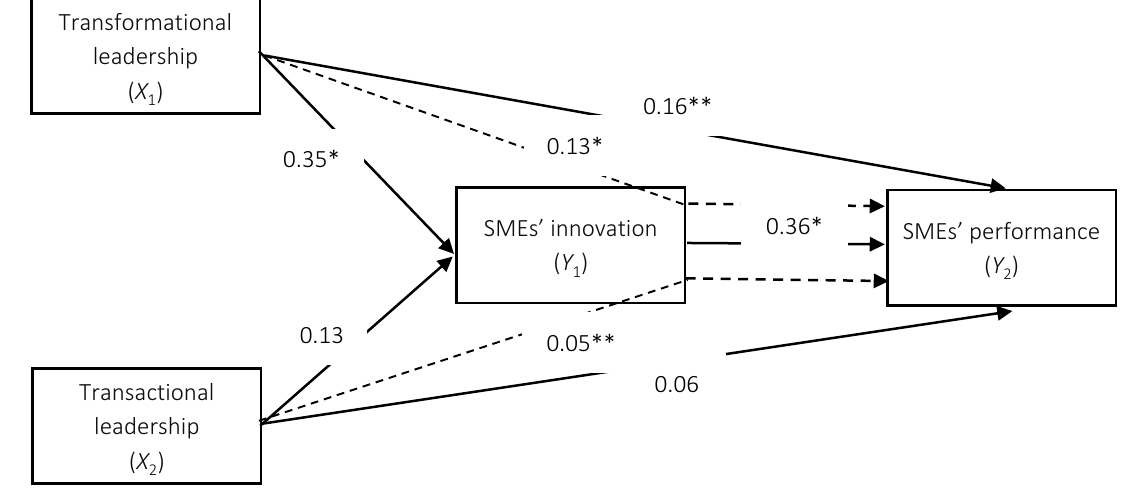
Figure 2. The path coefficient of direct and indirect